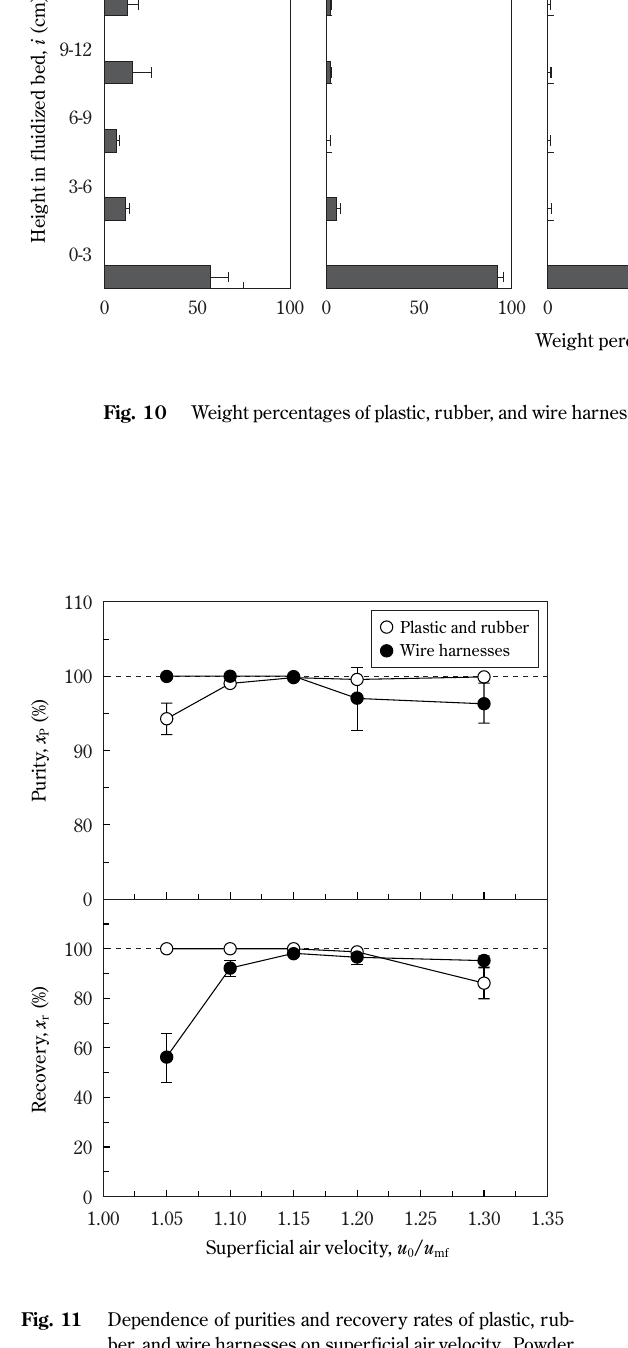
Fig. 11 Dependence of purities and recovery rates of plastic, rub- ber, and wire harnesses on superficial air velocity. Powder is